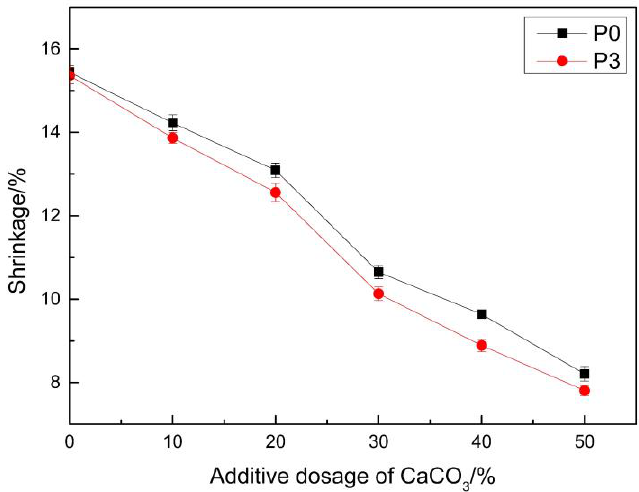
Figure 6. Effect of the different ratios of CaCO 3 on shrinkage. Table 3. Effect of the different ratios of CaCO 3 on viscosity.